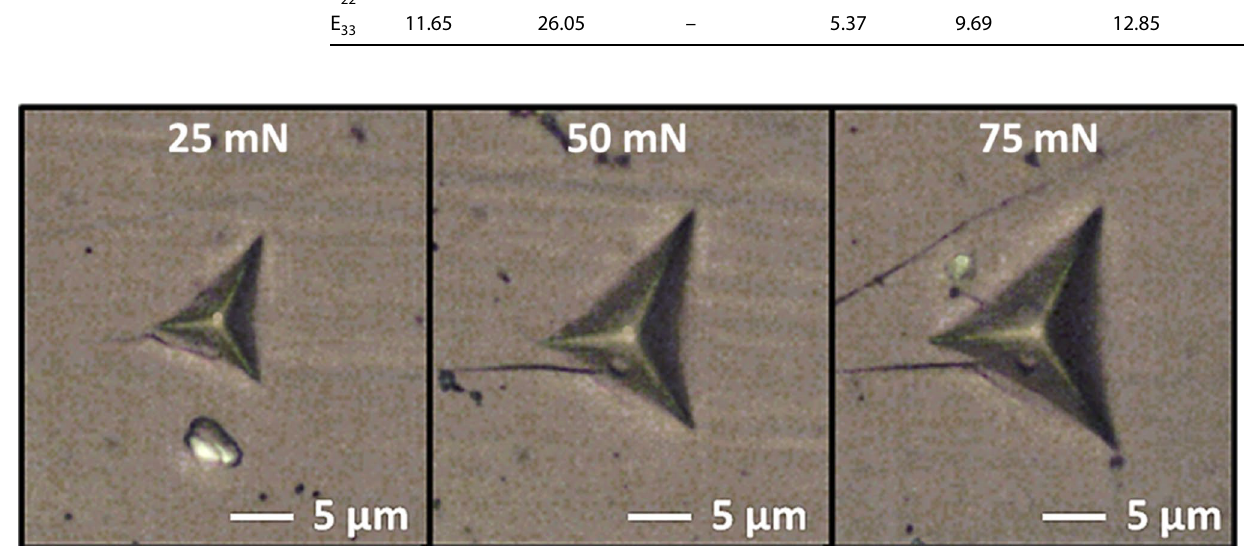
Table 1 Indentation moduli obtained from this work in comparison to elastic moduli presented in published works